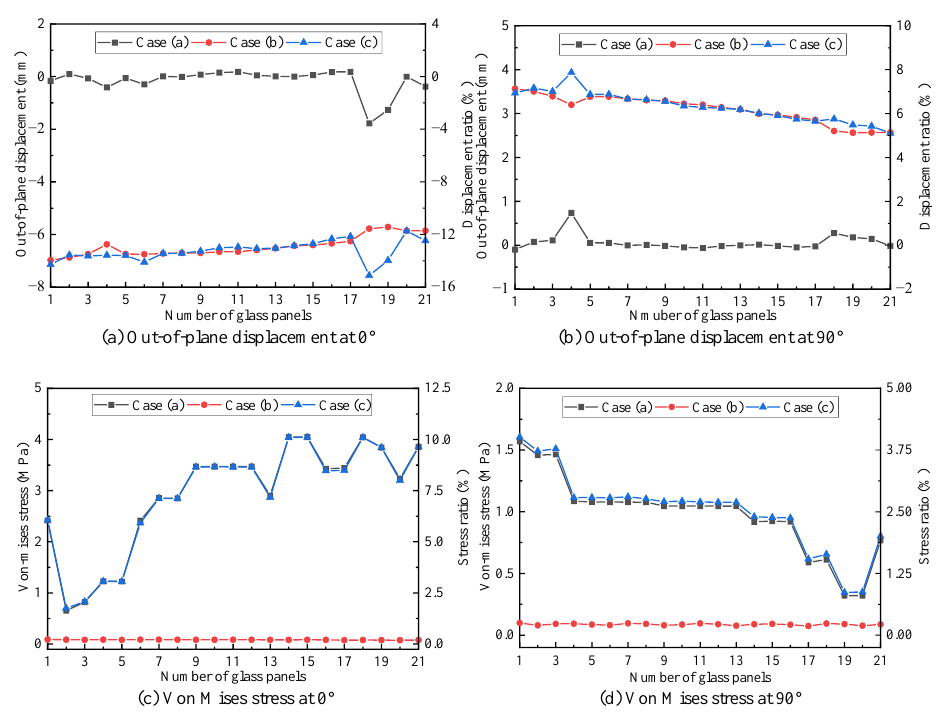
Figure 12. Responses at the location of each glass panel with peak additional response. The responses of the LGCW induced by the wind loads on the LGCW reach peak values at the center of each glass panel, while the peak values of the additional response of the LGCW caused by the deformation of the high-rise building appear at the top edge of each glass panel. The deformation of the high-rise building significantly influences the out-of-plane displacements of the LGCW, especially in the top area of each glass panel, but slightly influences the stresses of the LGCW. Based on the above, the effects of the deformation of the high-rise building on the out-of-plane displacements of the LGCW should be considered, especially the responses at the top edge of the